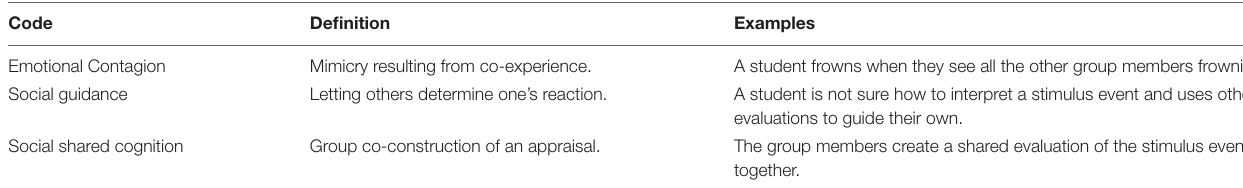
TABLE 5 | Appraisal codes—interpersonal